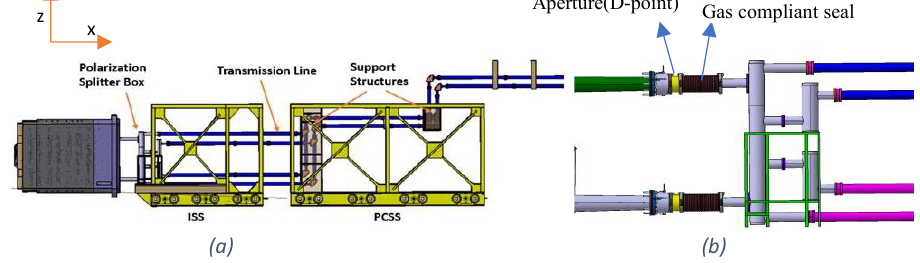
Figure 1: (a) showing the port plug and Ex-vessel TL including Polarization Splitter Unit, in the ISS and PCSS, (b) showing the gas compliant seal, aperture (D-point) and ex-vessel TL (Polarization Splitter Unit)